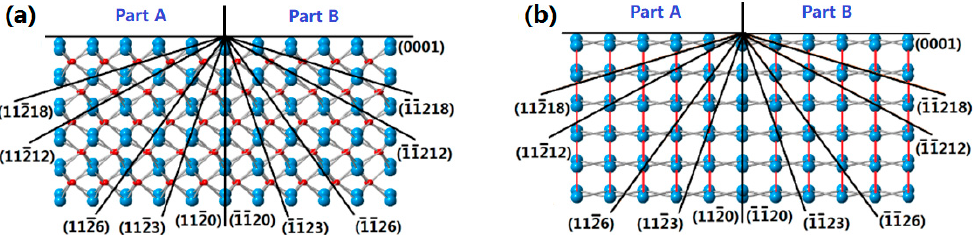
Figure 7. The schematic diagram of atomic structures of di ff erent crystal planes in the < − 1 1 0 0> crystal zone: ( a ) based on the atomic structure of sapphire; ( b ) based on the simplified atomic structure of sapphire.